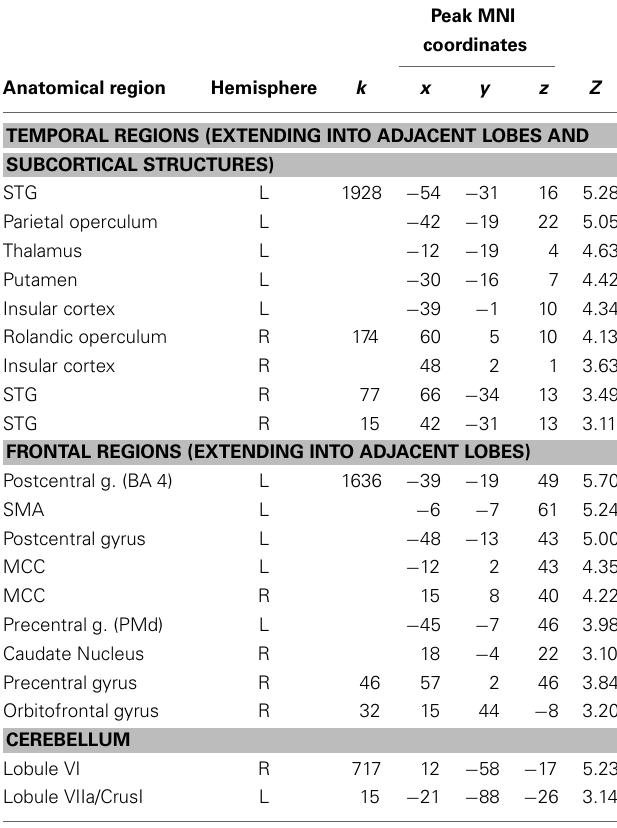
Table 4 | Peaks of increased brain activity during finger tapping (contrast